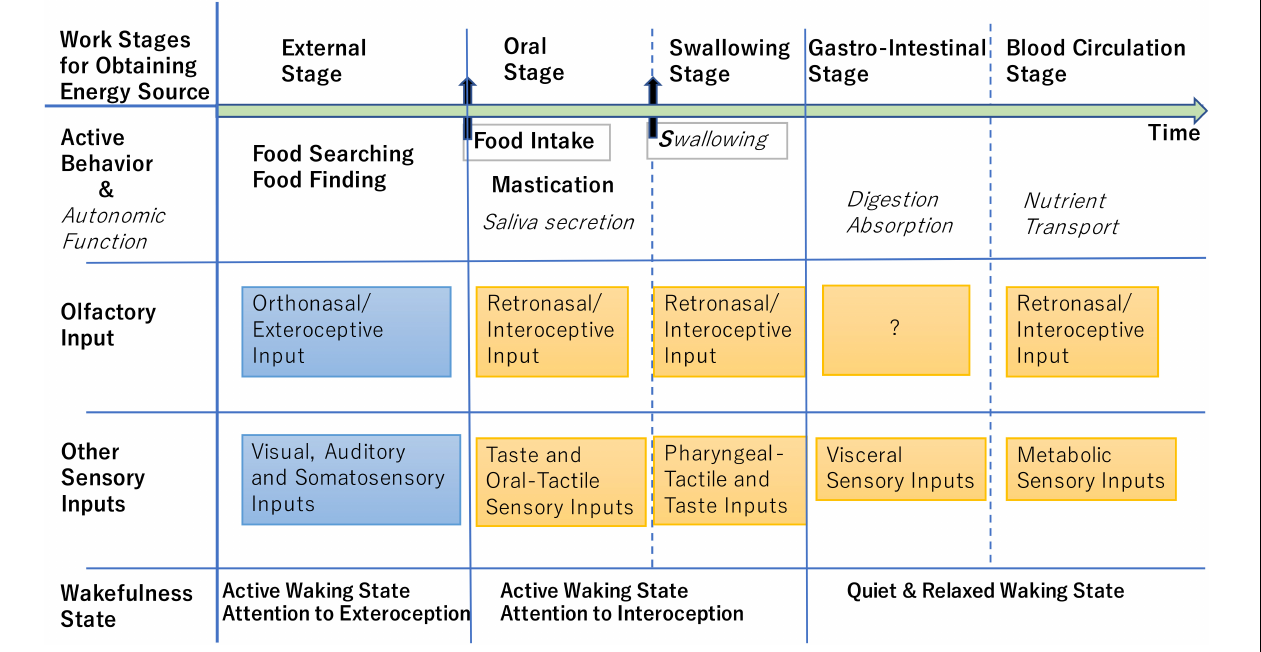
FIGURE 2 | Schematic diagram illustrating the stage-by-stage workflow for obtaining energy source. Active behavior and autonomic function in each stage are listed in the second row, while possible external and internal sensory inputs including stressors that occur in each stage are shown in the third and fourth rows. At the external stage, the brain shows active waking state (fifth row) and attends to the orthonasal/exteroceptive odor information and other exteroceptive sensory information (blue boxes). At the oral and swallowing stages, the brain shows active waking state attending to the retronasal/interoceptive odor information and other interoceptive sensory information (orange boxes). At the gastrointestinal and blood-circulation stages, the brain shows quiet and relaxed state with reduced attention to the exteroceptive and interoceptive sensory inputs (Brown et al., 2012). At any stage, retronasal detection of aversive odors indicating metabolic abnormality may alert the animal and induce the stress responses (Bollen and Beikler, 2012; Poniewierka et al.,